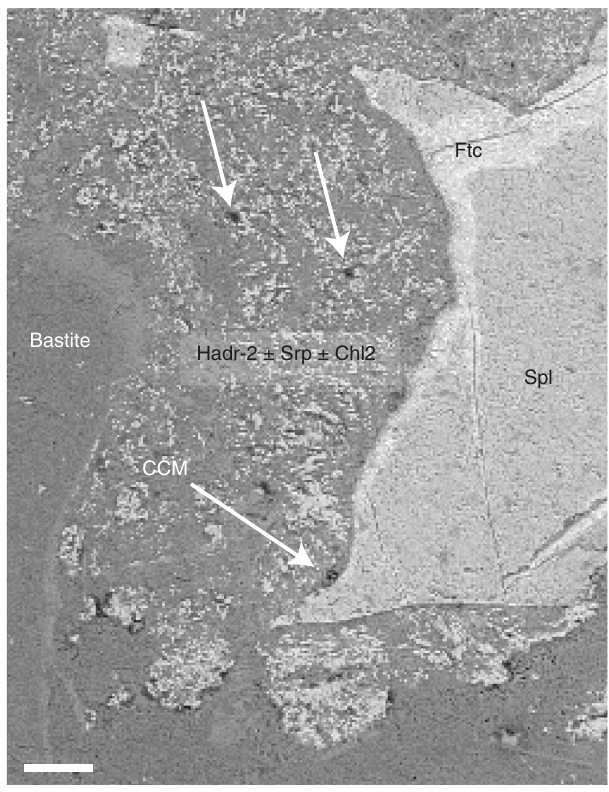
Fig. 4 Association of CCM with ferritchromite (Ftc) rims contouring altered primary spinel and pseudomorphosed plagioclase substituted by Chl2 ± Srp ± Hadr-2 (PPFtc assemblage). Backscattered electron SEM images showing the presence of rare and small patches of condensed carbonaceous material (CCM-PPFtc), highlighted by white arrows. Scale bar corresponds to 50 µ m